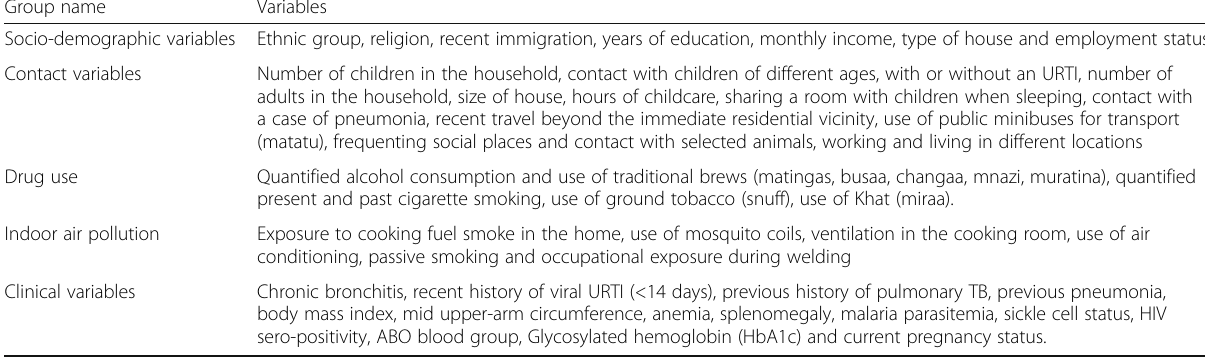
Table 1 Variable categories for the intermediary logistic regression models Group